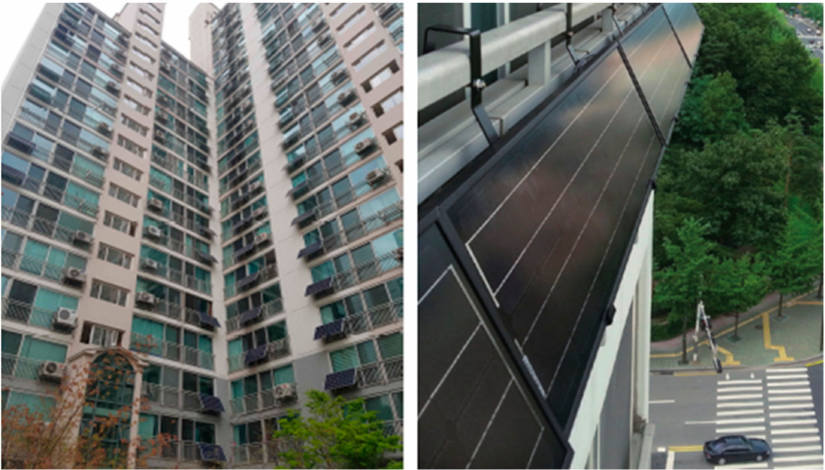
Figure 1. Mini-solar photovoltaics (PVs). Source: Seoul Metropolitan Government, Seoul Sustainable Energy Action Plan